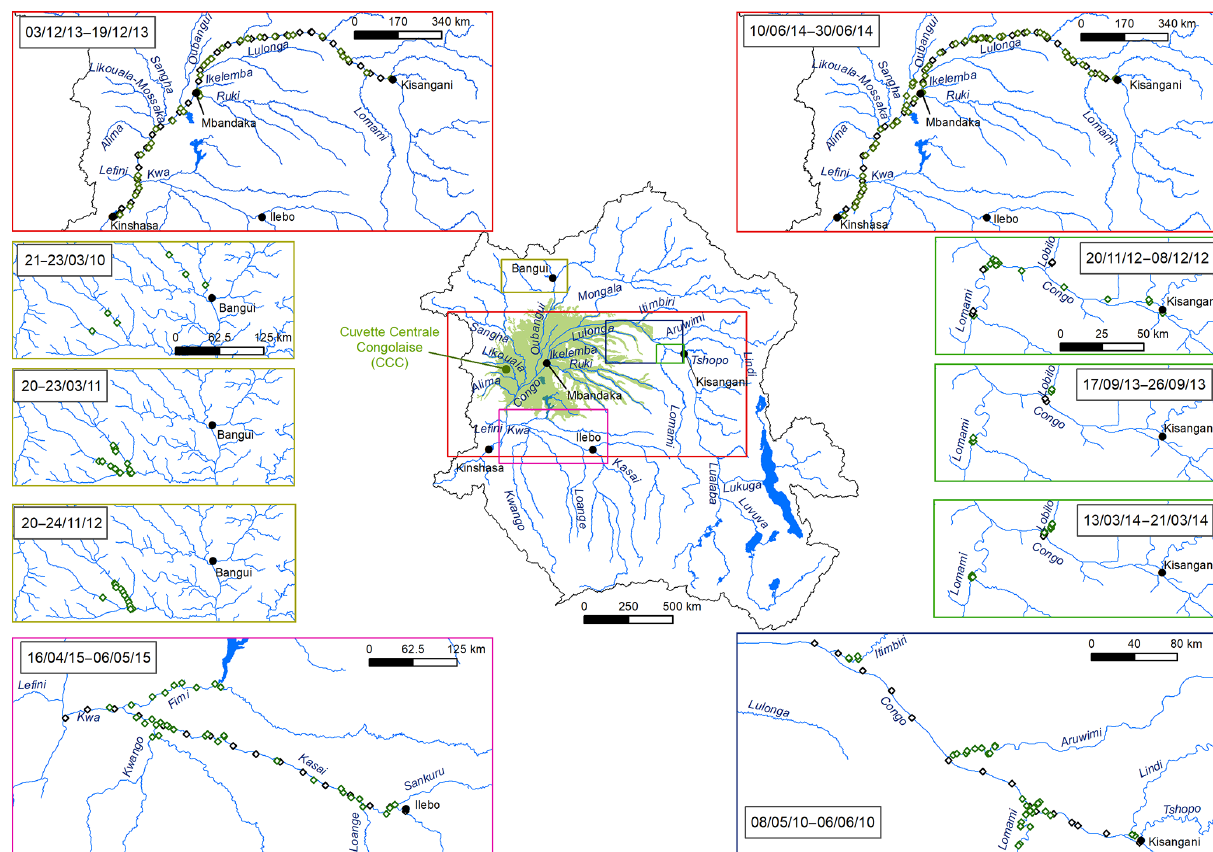
Figure 2. Map showing the sampling stations of the 10 field expeditions in the Congo River network.